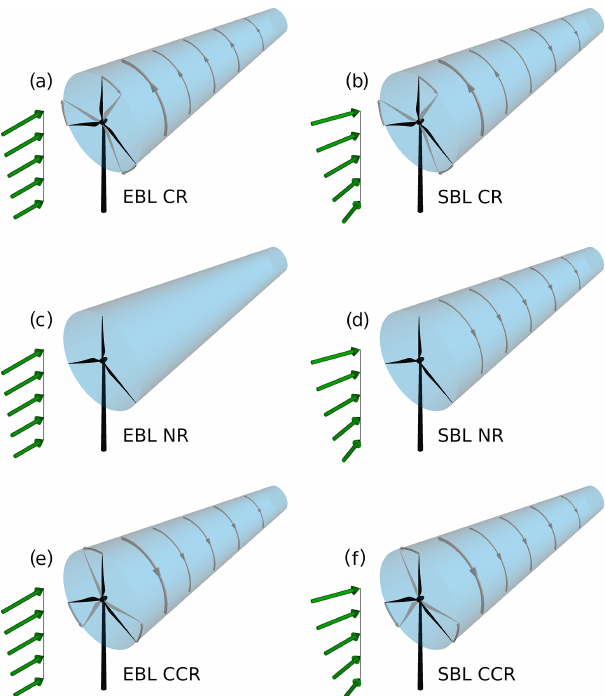
Figure 1. Schematic illustration of the rotational direction of the wake for the following cases: no wind veer with clockwise blade rotation (EBL CR) in (a) , wind veer with clockwise blade rotation (SBL CR) in (b) , no wind veer with no blade rotation (EBL NR) in (c) , wind veer with no blade rotation (SBL NR) in (d) , no wind veer with counterclockwise blade rotation (EBL CCR) in (e) , and wind veer with counterclockwise blade rotation (SBL CCR) in (f)